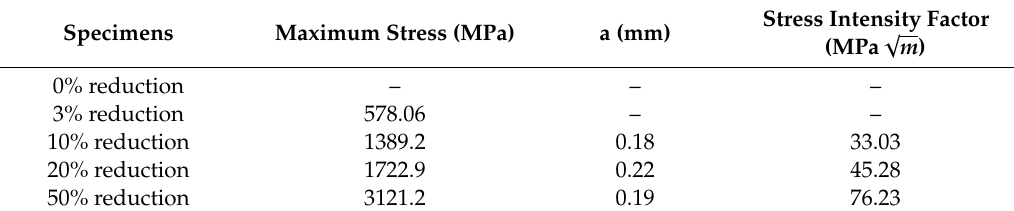
Table 9. Maximum stress from FEM simulations, crack depth (a), and stress intensity factors of the corroded tensile specimens.